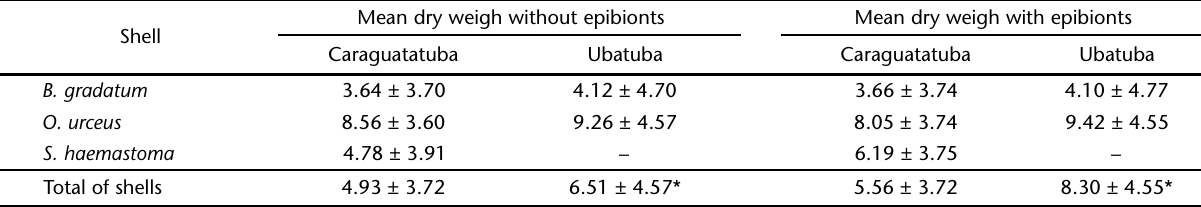
Table I. Mean dry weight (g) and standard deviation of the three species of gastropod shells that were most often occupied by L. loxochelis , with and without epibionts (without removing the cover on the outer surface), collected in Caraguatatuba and Ubatuba, from July 2002 through June 2003. (*) Significant difference, ANOVA, p <